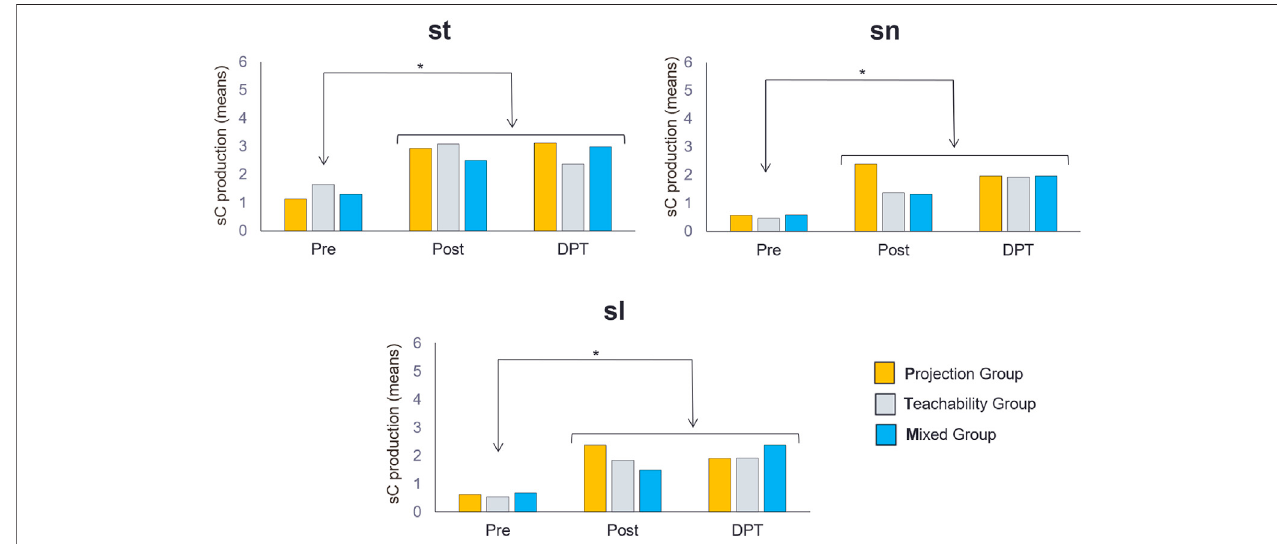
FIGURE 3 | Group Means on Listen and Repeat Test Over Time. Note. Signi fi cance: * p < 0.001.